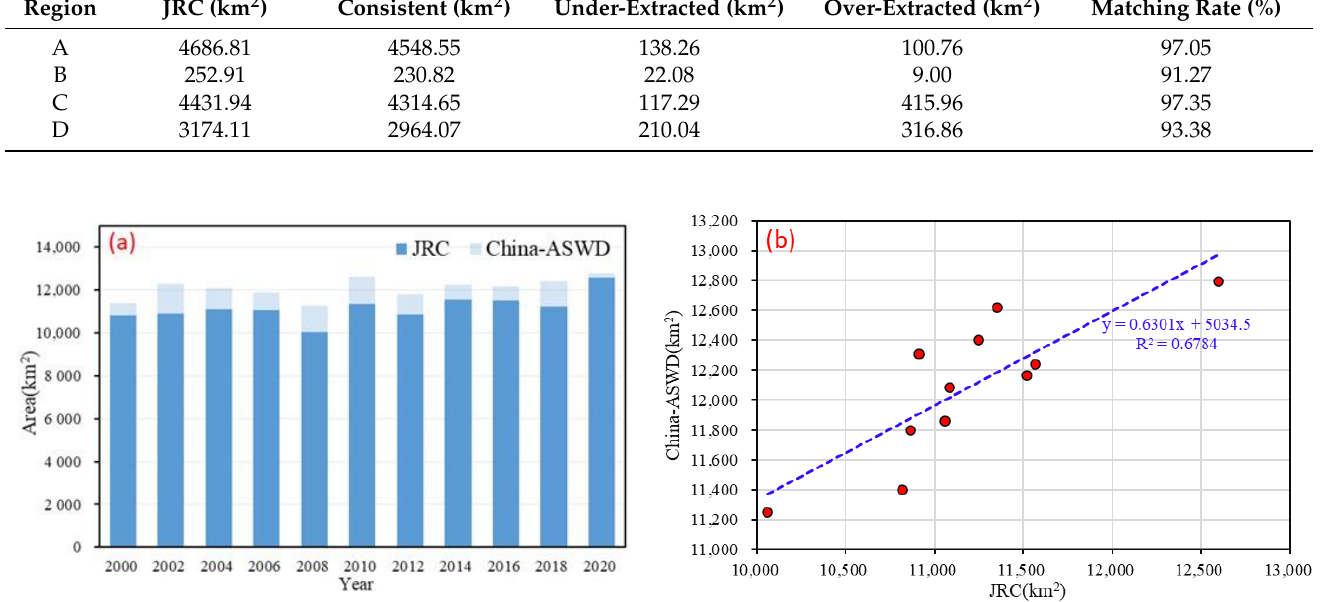
Table 2. Comparison and verification of China’s artificial water body data and other dam location data sources in